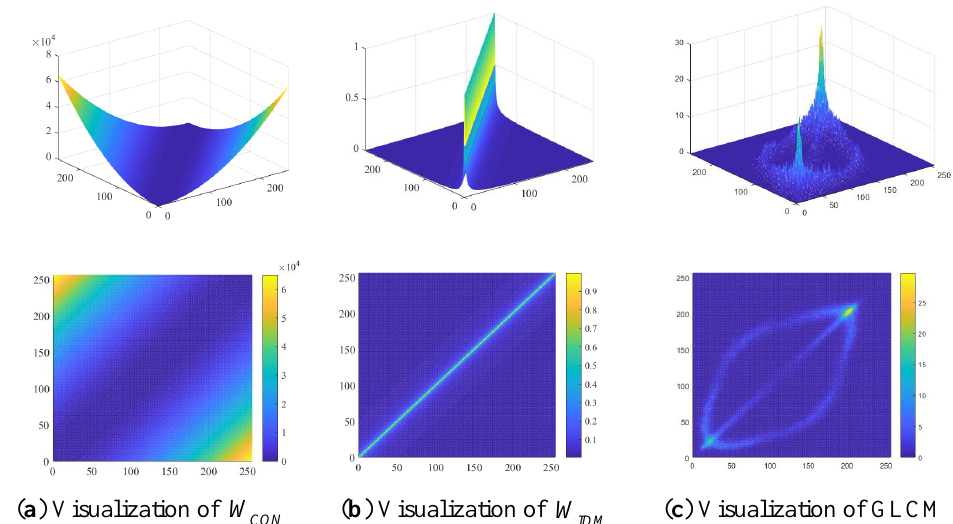
Figure 1. Visualization of weighting matrices W CON , W IDM and GLCM from different viewing